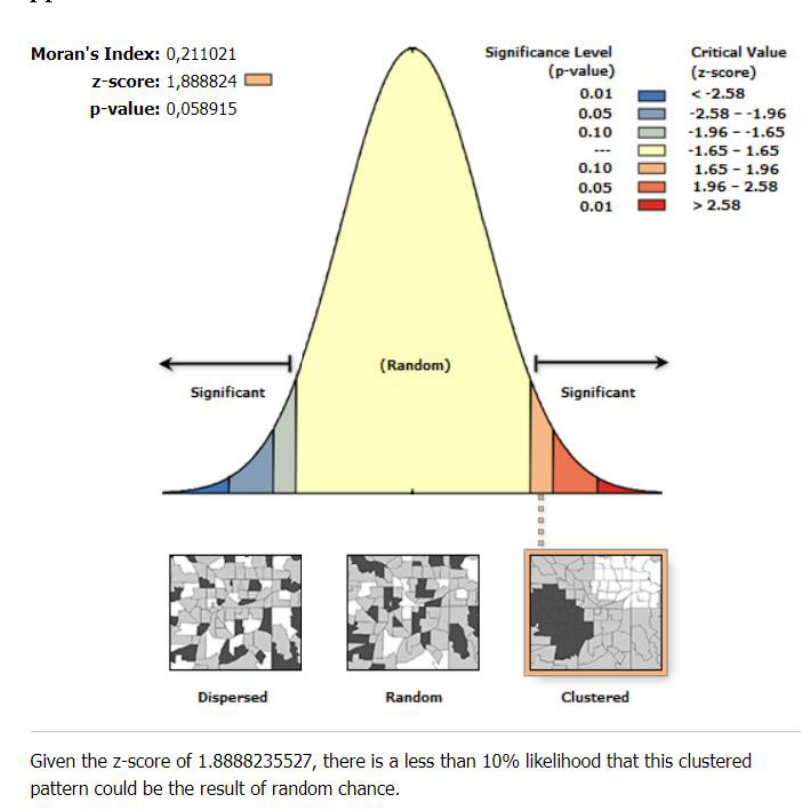
Figure A1. Global Moran ’ s I Spatial autocorrelation results.